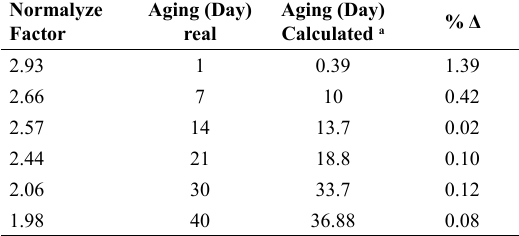
Table 6. Comparison between real aging time and predicted ones by TGA factor Normalyze Aging (Day) Factor real